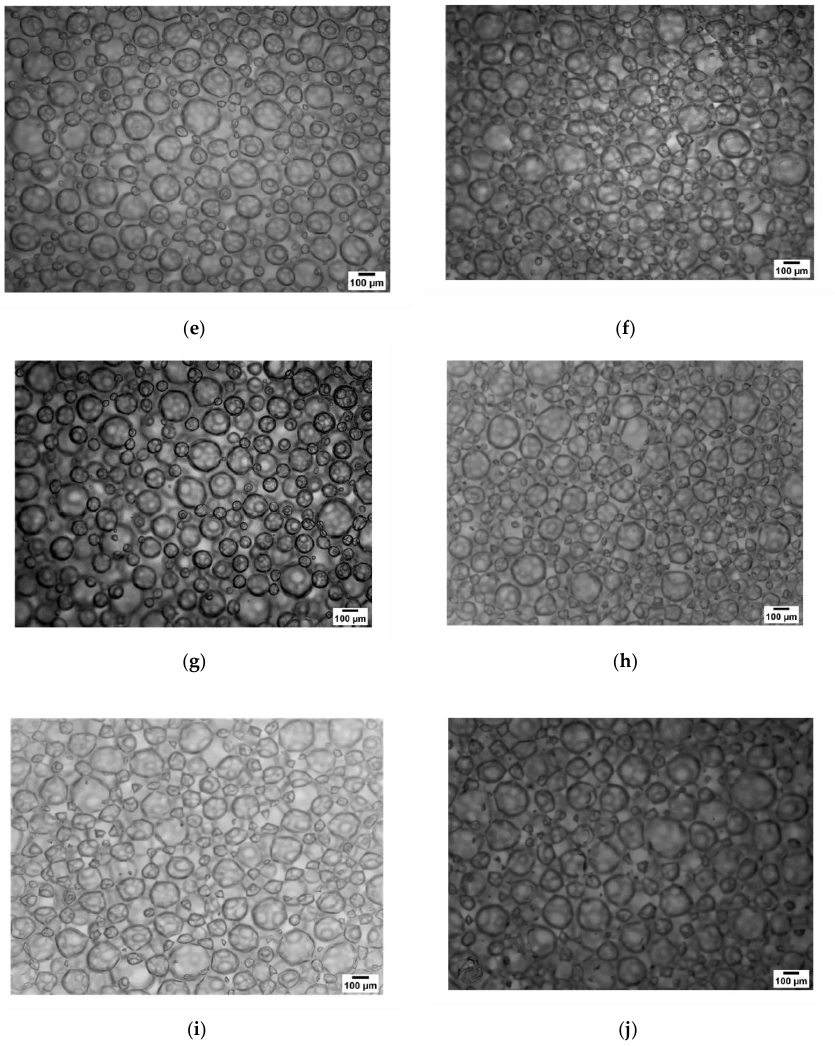
Figure 1. Optical microscopy (100×) of aerated CBJ–gelatin gels under different days of storage: ( a ) M1, day 1; ( b ) M1, day 28; ( c ) M2, day 1; ( d ) M2, day 28; ( e ) M3, day 1; ( f ) M3, day 28; ( g ) M4, day 1; ( h ) M4, day 28; ( i ) M5, day 1; ( j ) M5, day 28.